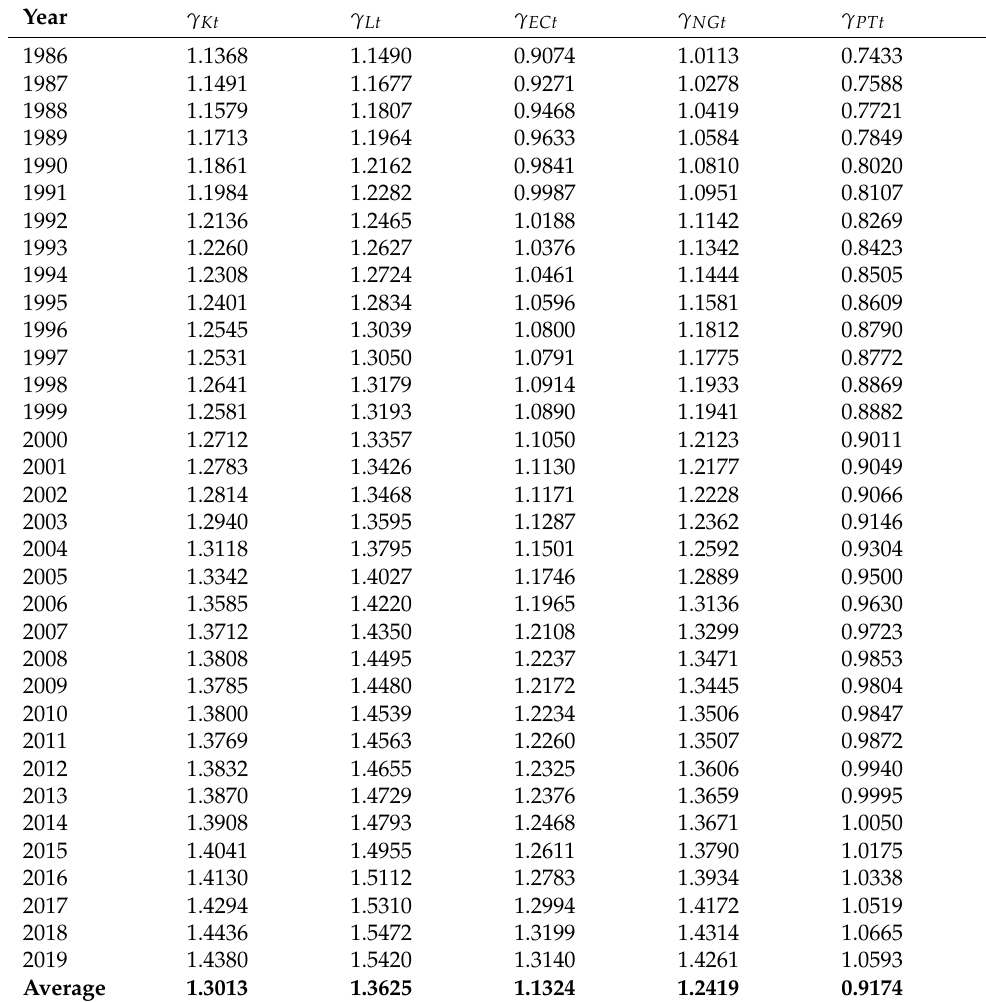
Table 3. Output elasticities among alternative inputs from